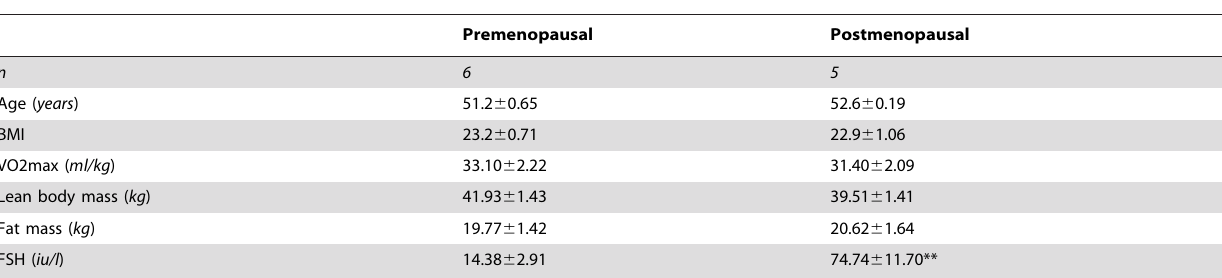
Table 1. Subject